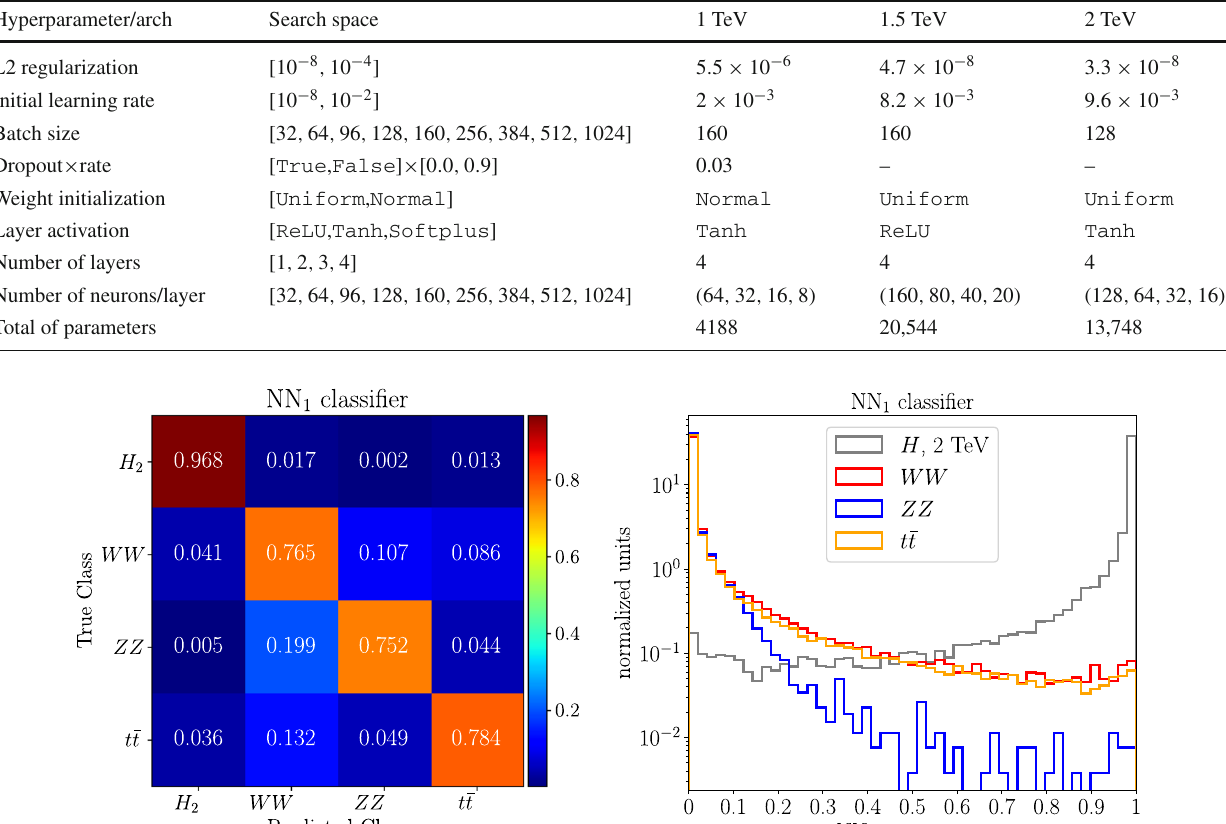
with a stronger L2 regularization, dropout layers, and a less complex architecture. It reflects the fact that it is harder to separate lighter resonances from the SM